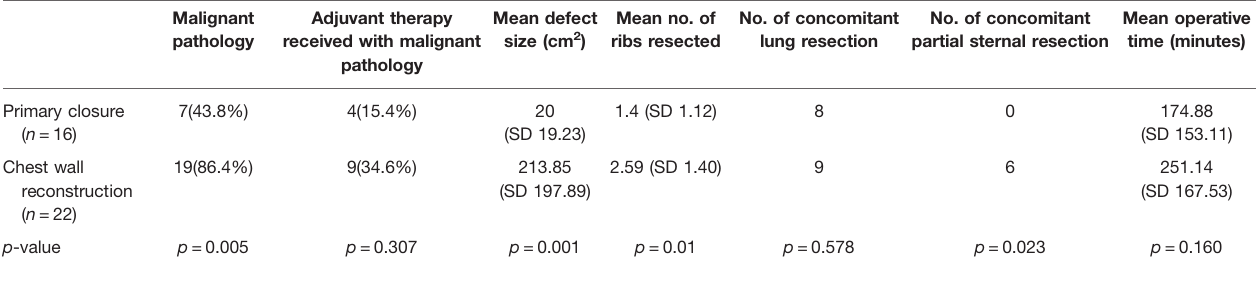
TABLE 2 | Operative variables — primary closure vs. chest wall reconstruction (both MatrixRIB ™ implantation and prosthetic patch/autologous fl ap repair). Malignant pathology